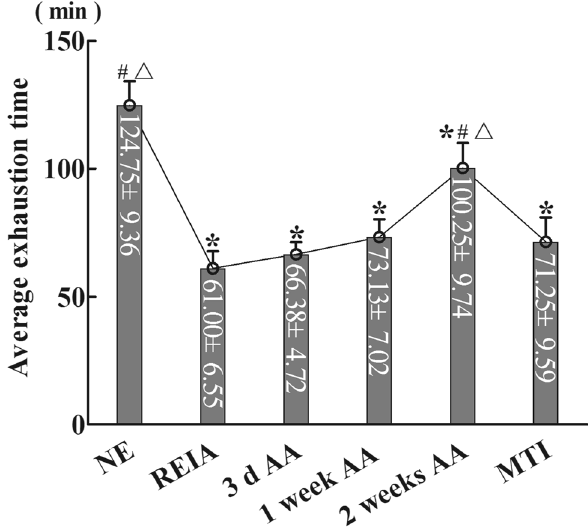
Figure 1. Average exhaustive time in minutes of load exercise of rats in each group. Data are presented as the mean ± SD. *P < 0.05 vs. the NE group, #P < 0.05 vs. the REIA group, △ P < 0.05 vs. the MTI group (ANOVA with post hoc Bonferroni correction; n = 9 per group).